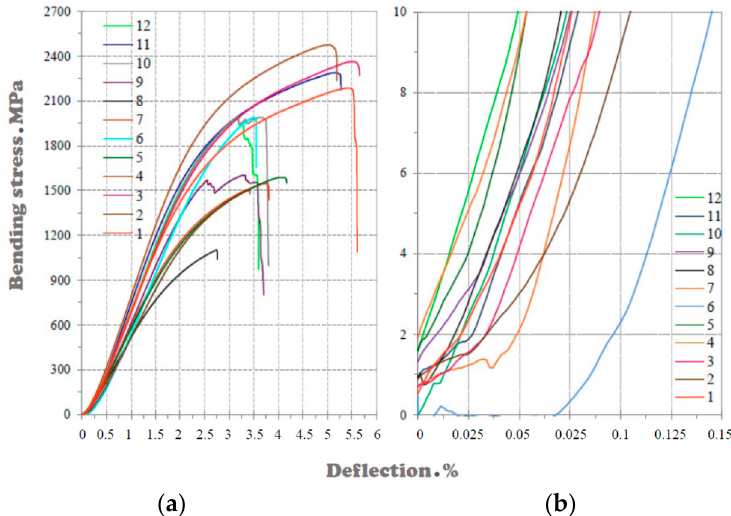
Figure 9. Charts of bending stress versus deflection for individual micro specimens manufactured in different conditions. ( a ) Full course of bending curves and ( b ) initial fragment of these charts at a significant magnification.